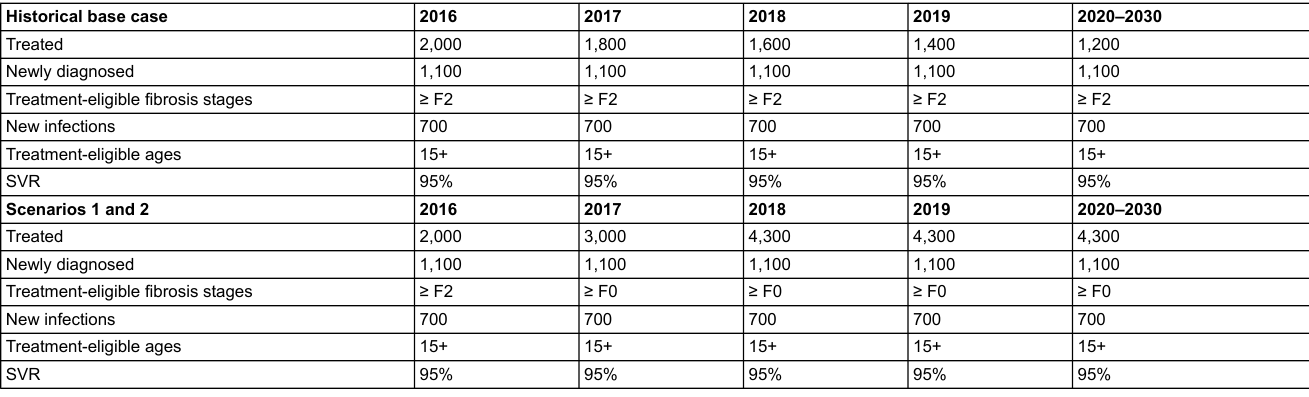
Table 1: Comparator (historical base case) and intervention (scenarios 1 and 2) scenario input parameters. Historical base